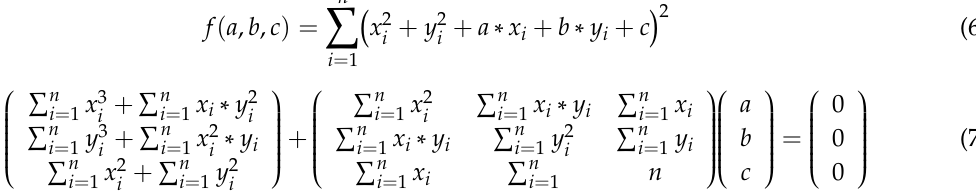
Figure 4. Smoothing the flow line by the cubic B-spline interpolation method.